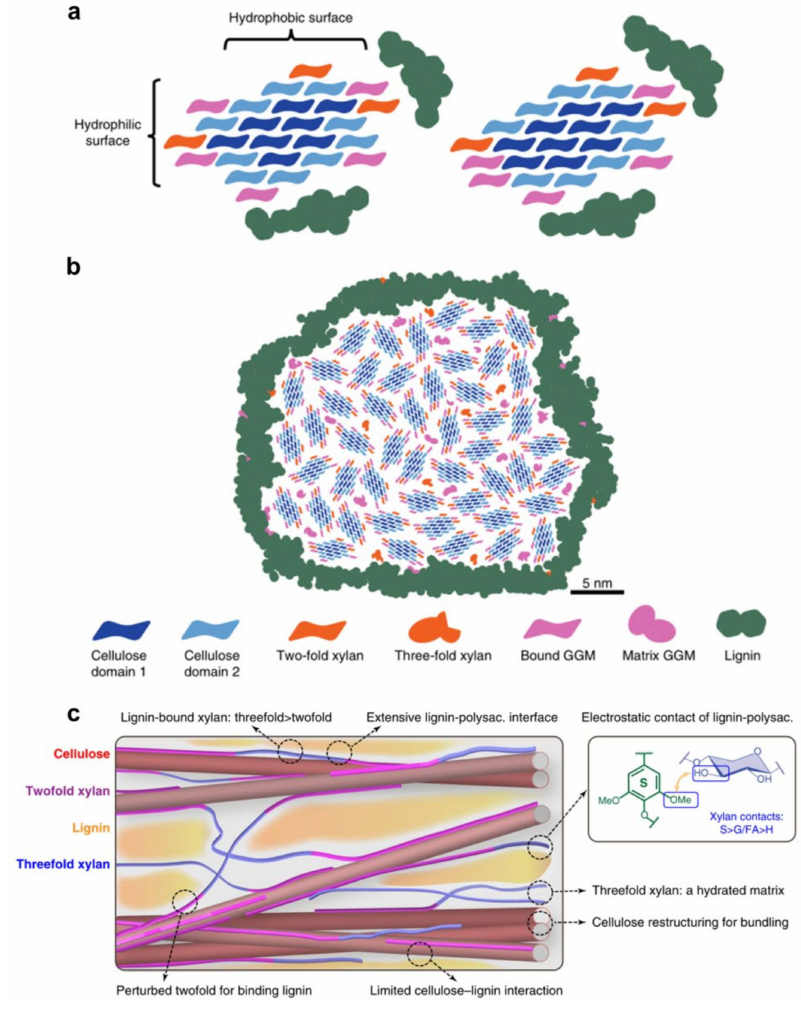
Figure 17. ( a ) Possible models of the molecular architecture of softwood; ( b ) Model of spruce cell wall macrofibril; ( c ) Secondary cell wall model by Kang et